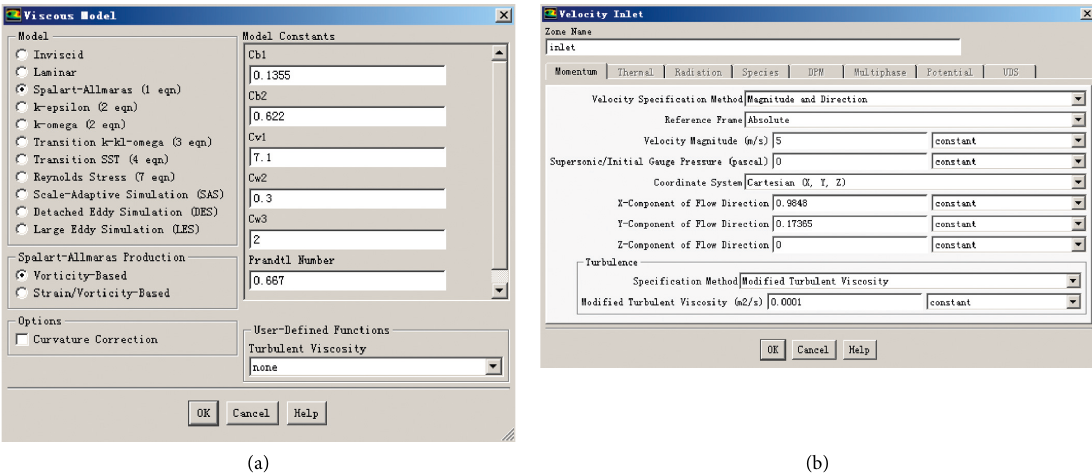
Figure 6: The settings of viscous model and velocity inlet in ANSYS FLUENTsoftware. (a): the settings of viscous model; (b): the settings of velocity inlet.